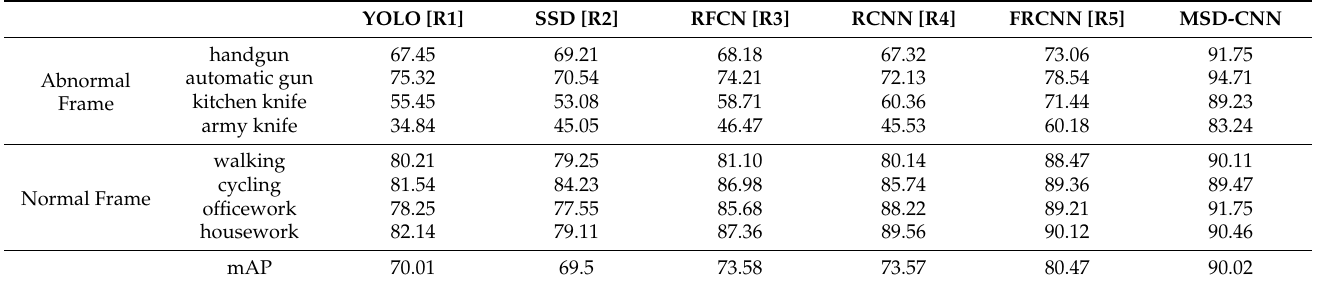
Table 6. Detection average precision for each subclass with different